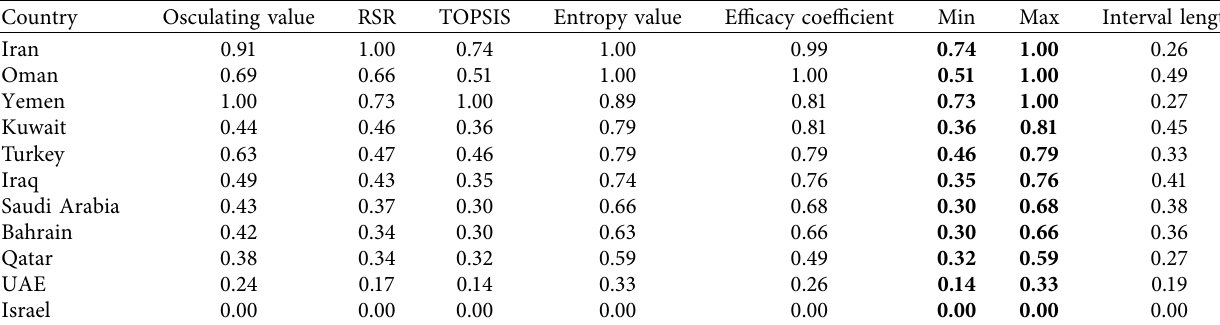
Table 11: Matching result of Chinese power companies in the Middle